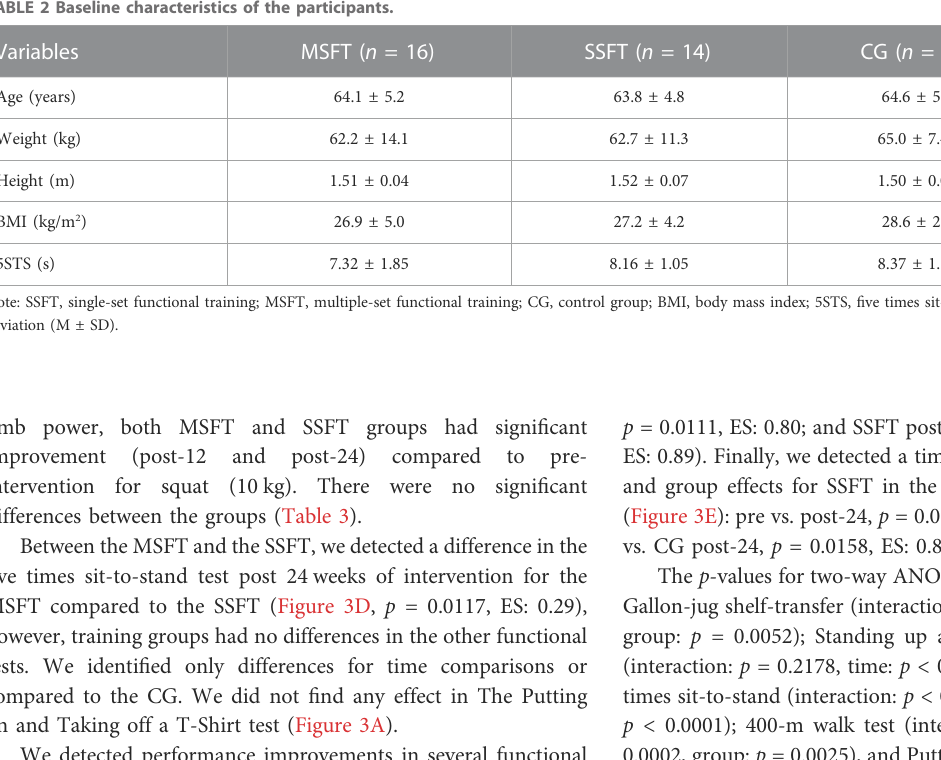
TABLE 2 Baseline characteristics of the